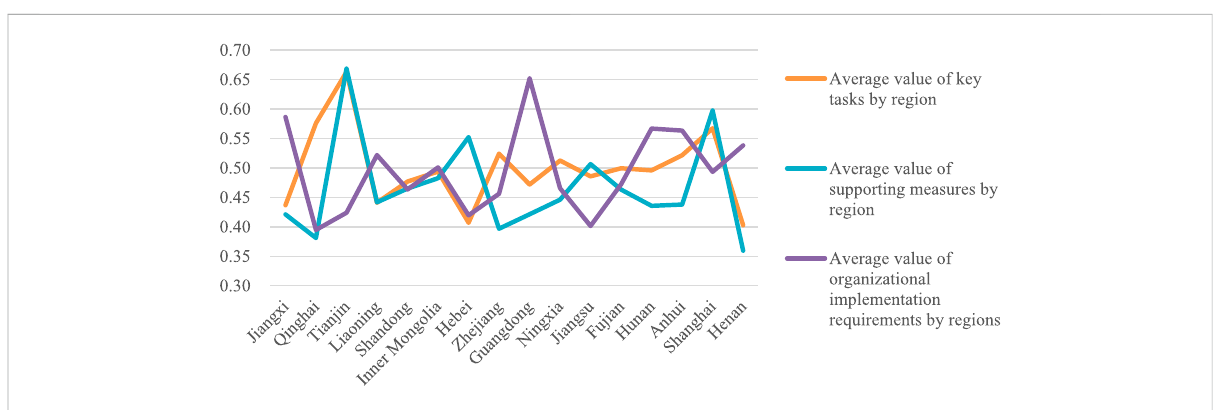
FIGURE 7 Average similarity of three deployment contents of different